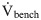
Bench hardware diagram.PTG: pneumotachograph; V˙bench: bench airflow measured by a pneumotachograph; Pus: pressure at upstream of Starling resistor; Pch: sealed chamber pressure in Starling resistor; TTL signal: transistor-transistor logic signal.